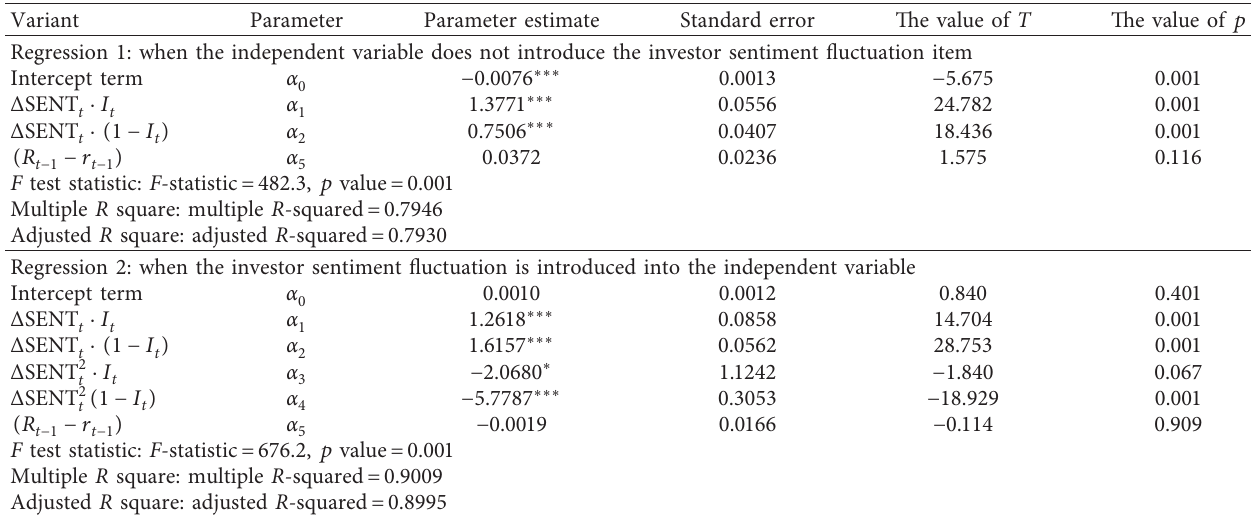
Table 2: Linear regression results of